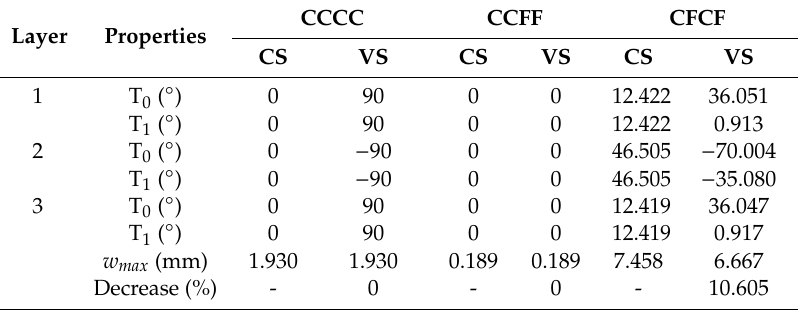
Table 18. Optimum angles for a three-layer VS plate minimum, maximum transverse deflection. CCCC, CCFF, and CFCF boundary